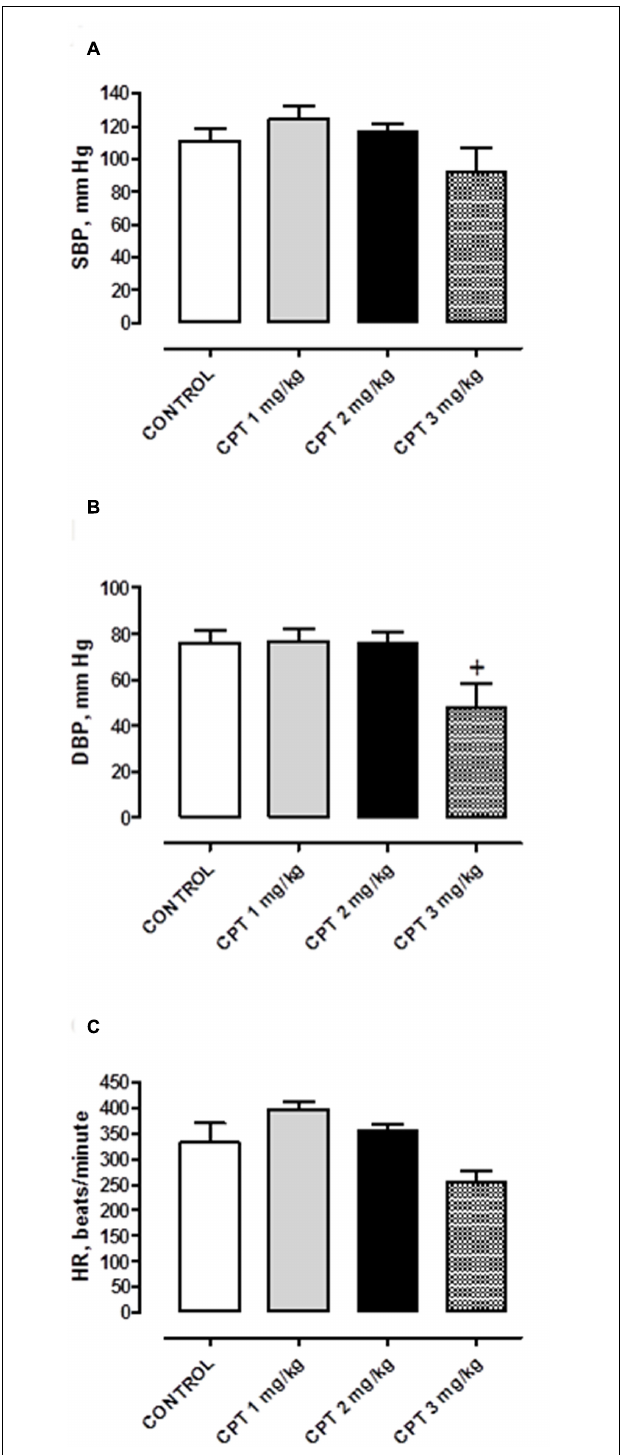
FIGURE 1 | (A) Systolic blood pressure (SBP), (B) diastolic blood pressure (DBP), and (C) heart rate (HR) of anesthetized animals chronically treated with saline (CONTROL) or cisplatin (CPT) 1 mg/kg, 2 mg/kg or 3 mg/kg. Data represent the mean ± SEM, n = 10–15 animals per experimental group. A one-way ANOVA followed by Bonferroni/Dunn post hoc test was used for statistical analysis ( + P < 0.05, CPT 3 mg/kg vs. control).